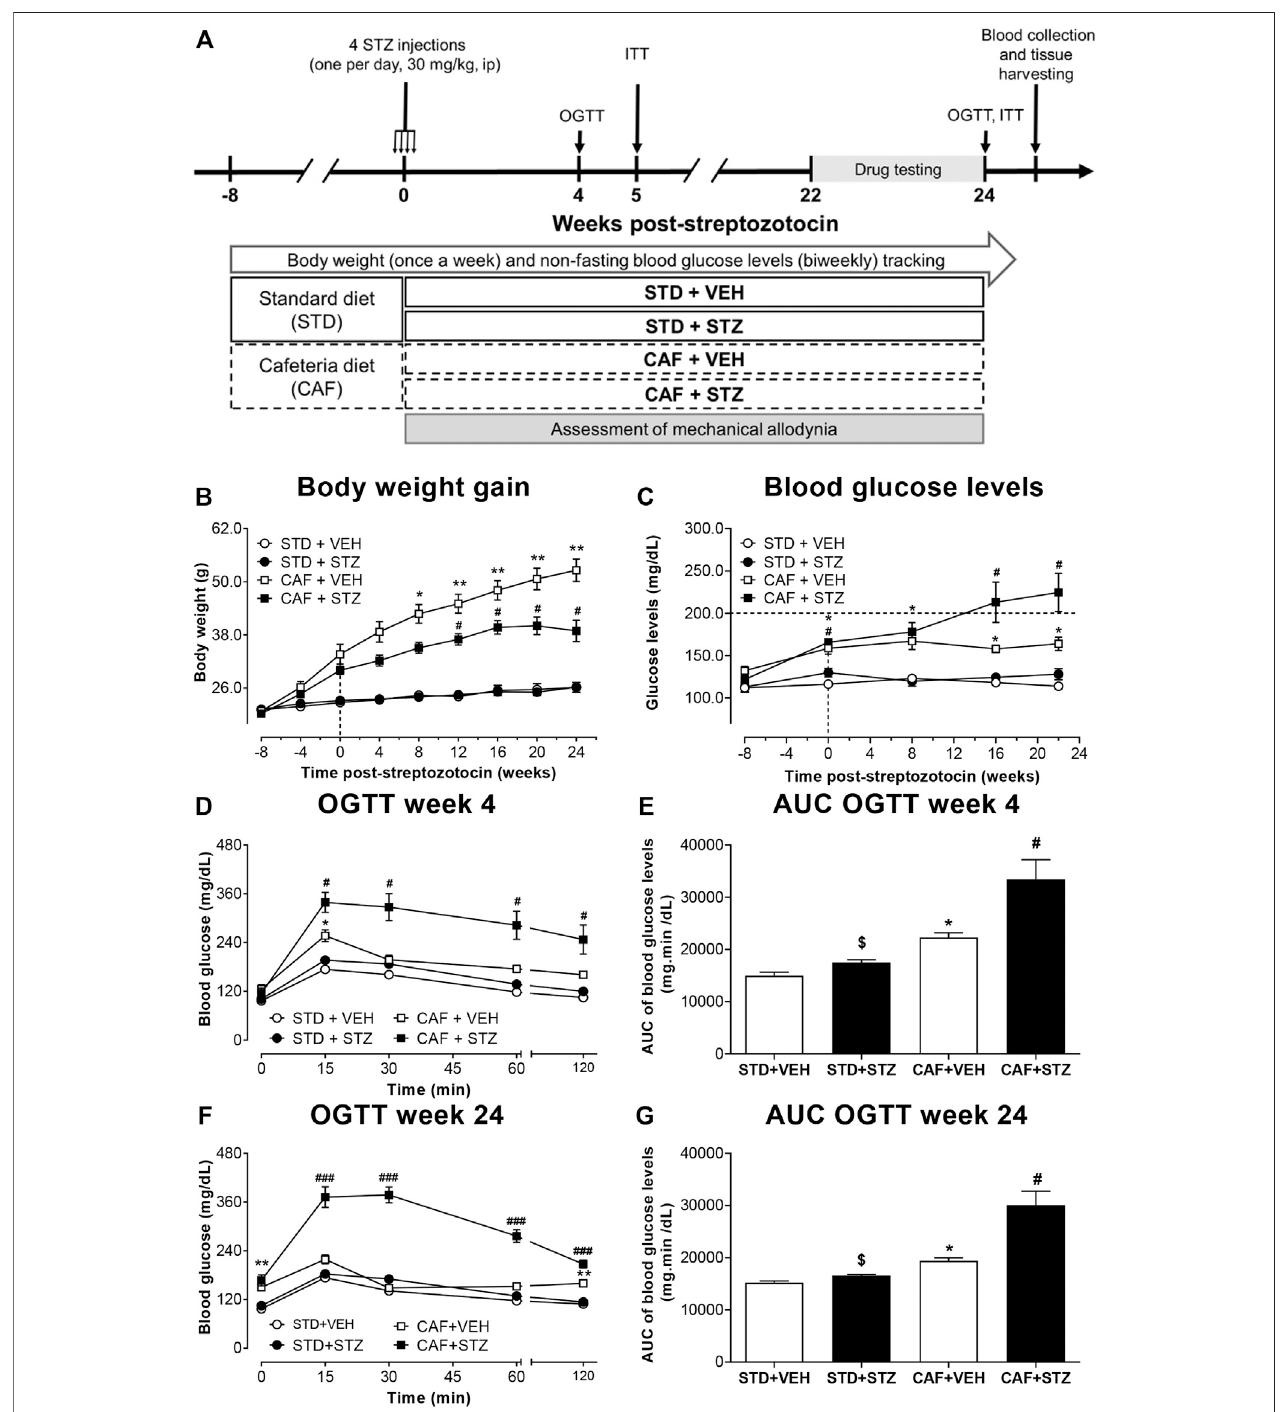
FIGURE1| Outlineoftheexperimentaldesign (A) and changesinbodyweight (B) ,blood glucoselevels (C) ,and glucosetolerance (D – G) inmice.Female C57BL/ 6Jmiceat8 weeks-oldwerefedeithercafeteria(CAF)orstandard(STD)dietandinjectedwithvehicle(VEH)orstreptozotocin(STZ).Eightweekslater,CAForSTDmice wereadministeredeitherwithfourlow-dosesofSTZ(30 mg/kg,i.p.,oneperday)orvehicle.Valuesaremeans ± SEM(n (cid:1) 10).In (B) * p < 0.05,** p < 0.01forCAF[F (1,36) (cid:1) 109.5]. *, # p < 0.05 for the interaction CAF × STZ [F (1,36) (cid:1) 7.94]. In (C) * p < 0.05 for CAF [F (1,36) (cid:1) 74.11] # p < 0.05 for the interaction CAF × STZ × Time [F (1,36) (cid:1) 3.10].In (D) * p < 0.05forCAF[F (1,36) (cid:1) 33.84],# p < 0.05fortheinteractionCAF × STZ × Time[F (1,36) (cid:1) 6.82].In (F) * p < 0.05forCAF[F (1,36) (cid:1) 150.6],### p < 0.001forthe interactionCAF × STZ × Time[F (1,36) (cid:1) 22.16].Notably,theinteraction CAF × STZshowedanimportanteffectonthevariable(F (cid:1) 48.8, p < 0.05).In (E) * p < 0.05forCAF [F (1,36) (cid:1) 35.12],$( p < 0.05)forSTZ[F (1,36) (cid:1) 12.17],#( p < 0.05)fortheinteractionCAF × STZ[F (1,36) (cid:1) 4.75].In (G) * p < 0.05forCAF[F (1,36) (cid:1) 40.65],$( p < 0.05)forSTZ [F (1,36) (cid:1) 18.78], # ( p < 0.05) for the interaction CAF × STZ [F (1,36) (cid:1) 11.73]. Data in (B – F) were analyzed by Repeated-Measures Three-Way ANOVA, followed by Bonferroni ’ s. Data in (E) and (G) were analyzed by Two-Way ANOVA. OGTT: oral glucose tolerance test.